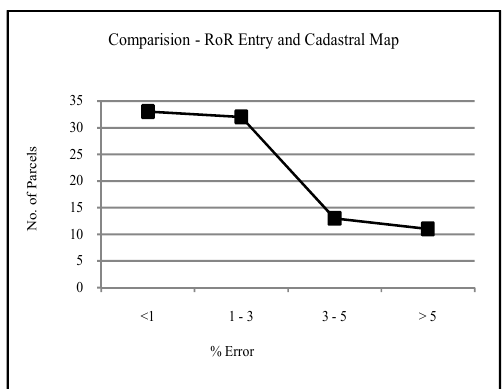
Table 2. Comparison Between Old RoR Records and Cadastral Map